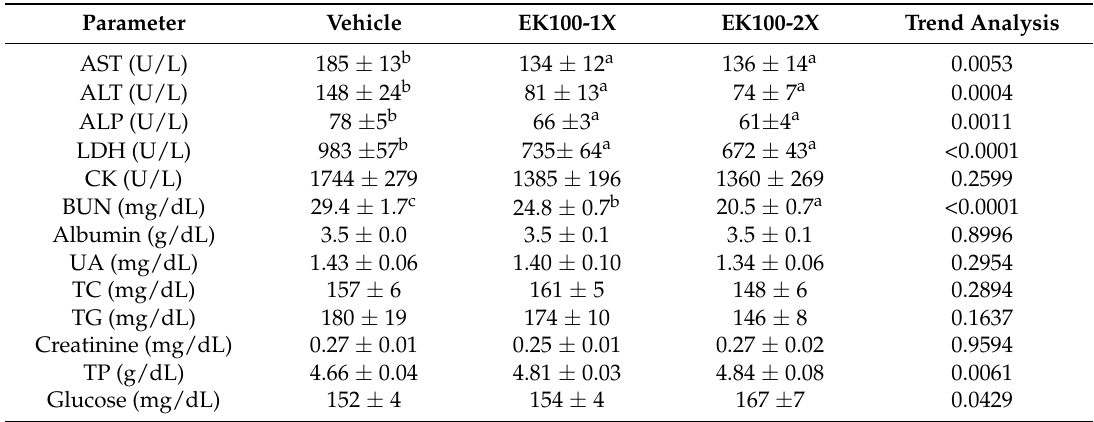
Table 2. Biochemical analysis of mice subjected to EK100 supplementation at the end of the study. Parameter Vehicle EK100-1X EK100-2X Trend Analysis AST (U/L) 185 ± 13 b 134 ± 12 a 136 ± 14 a 0.0053 ALT (U/L) 148 ± 24 b 81 ± 13 a 74 ± 7 a 0.0004 ALP (U/L) 78 ± 5 b 66 ± 3 a 61 ± 4 a